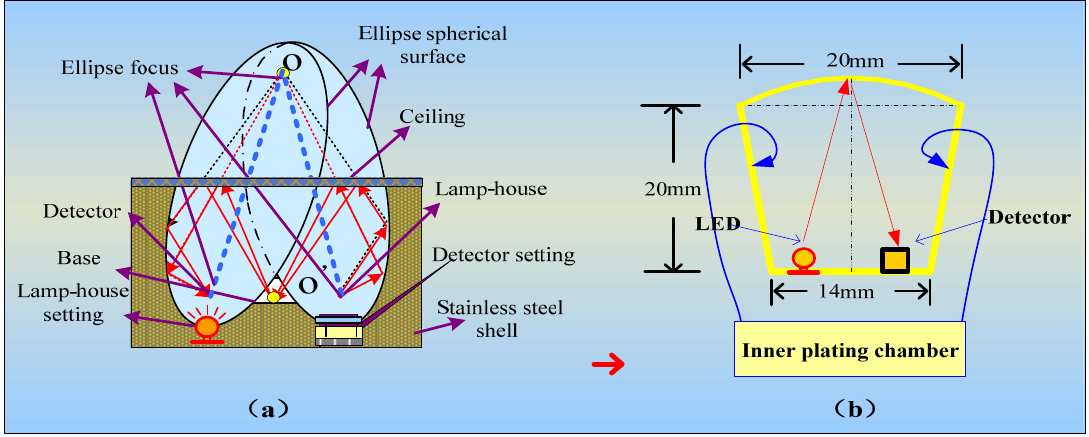
Figure 5. ( a ) Gas chamber optical path and ( b ) diagram of chamber